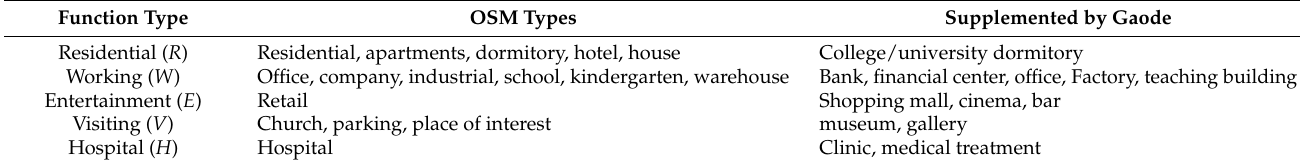
Table 3. Building function types and the corresponding OSM and Gaode